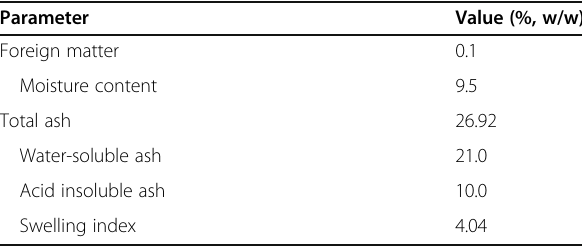
Table 1 Physicochemical investigation of Cucumis melo